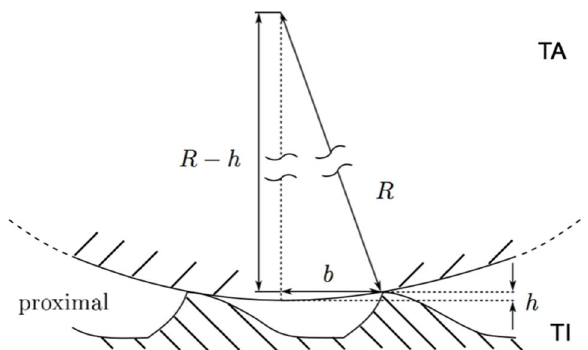
Figure 7. Tibia–tarsus leg joint of P. marginata . Schematic illustration of the penetration of the ball cap of the tarsus (TA) into the microstructure of the tibia (TI). R : radius of tarsus; h : penetration depth; b : half-width between two protuberances.